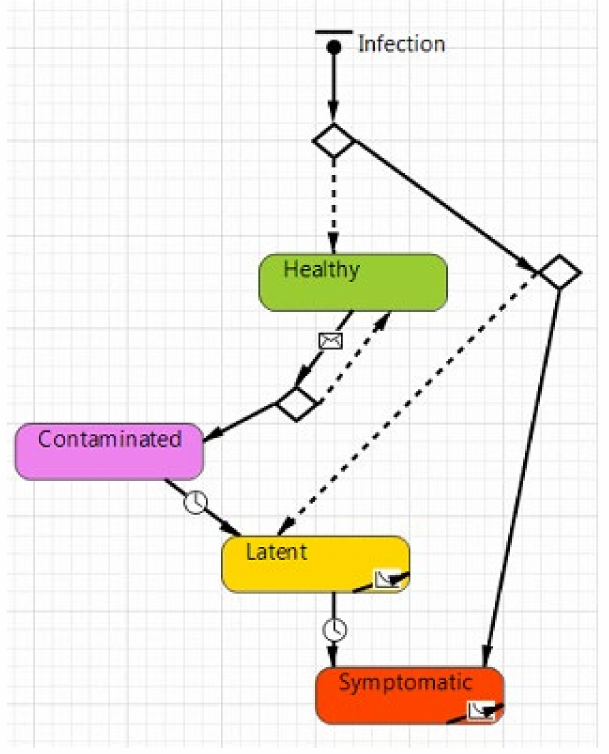
Figure 3. The agent-based model in